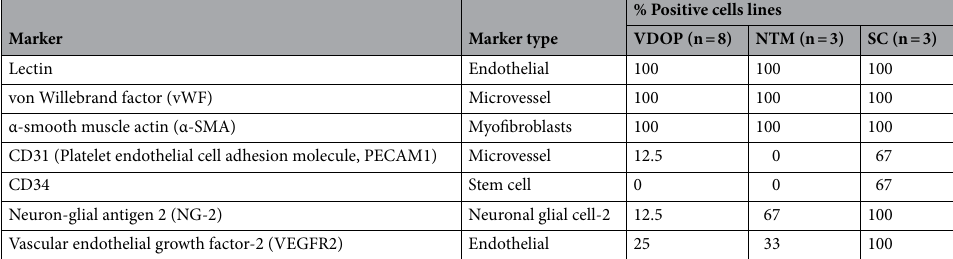
Table 2. Various phenotypic markers and their staining frequencies in VDOP, NTM and SC cell lines.